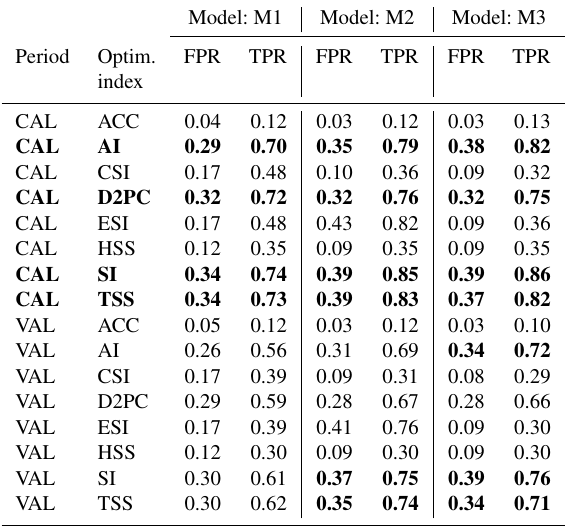
Table 4. Results in term of true-positive rate (TPR) and false- positive rate (FPR), for each model (M1, M2, and M3), for each optimized GOF index and for both calibration (CAL) and verifica- tion (VAL) data